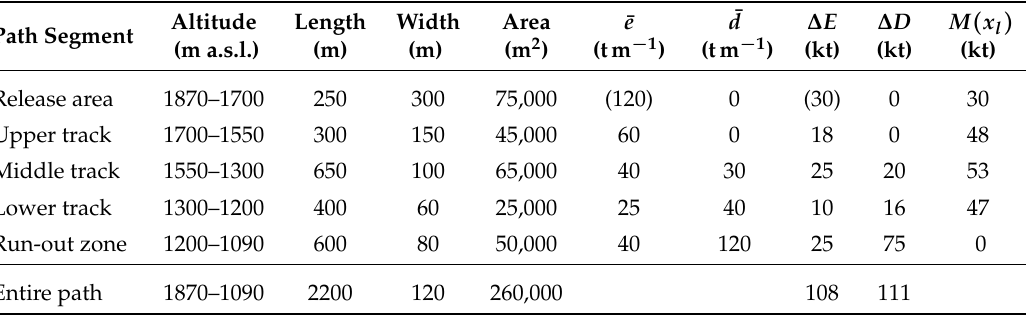
Table 2. Estimated snow mass balance of the 2017 Rigopiano avalanche. Length and area of the different sections are measured in horizontal projection. ¯ e and ¯ d are the spatial erosion and deposition rates, respectively, integrated over the path width. Integrating ¯ e and ¯ d over the segment length gives the changes of entrained and deposited mass, ∆ E and ∆ D . M ( x l ) is the estimate for the snow mass that flowed through the cross section at the lower end of the respective path segment. Numbers in parentheses for ¯ e and ∆ E in the release area are used for calculating M ( x l ) , but do not count for e ( x ) and E ( x ) in Figure